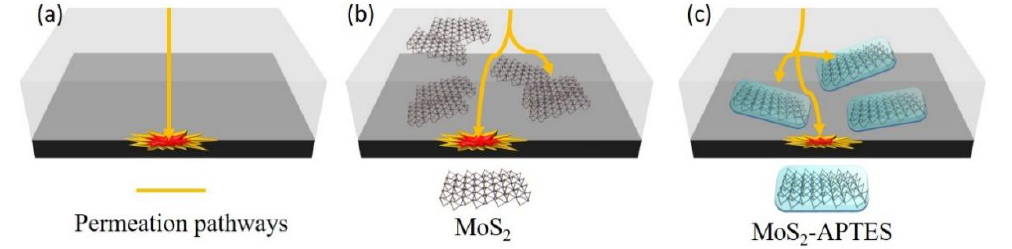
Figure 11. Schematic illustration of a corrosion protection mechanism for neat WEP ( a ), MoS 2 /WEP ( b ) and MoS 2 - APTES/WEP ( c ) coating.